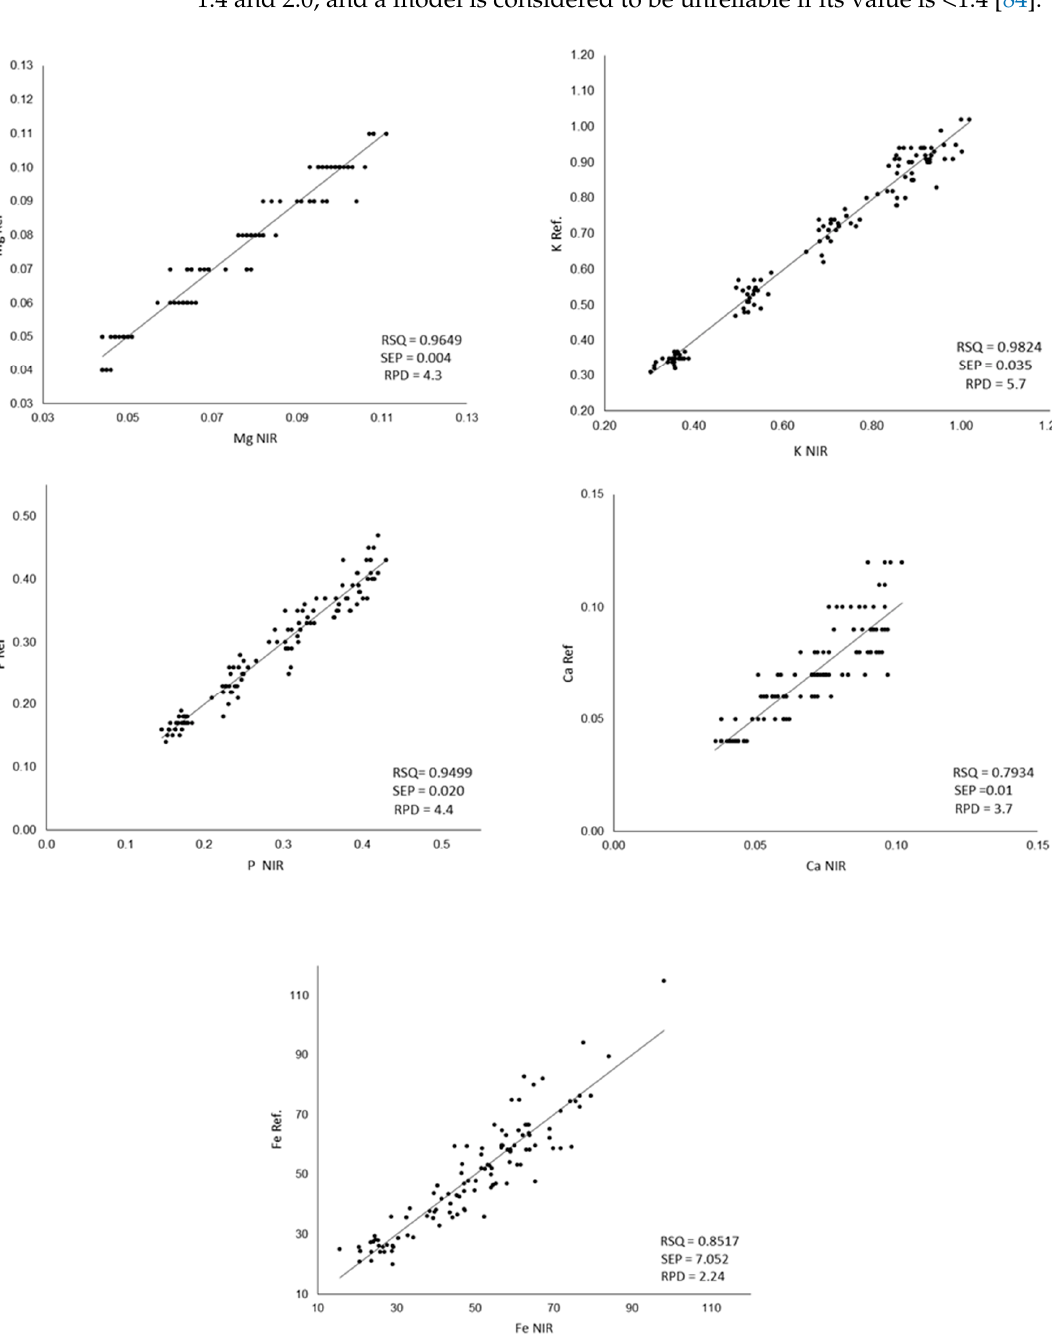
Figure 3. Comparison between the values measured by ICP-MS (Ref.) and the values predicted by the developed equations (NIR); RPD: ratio performance deviation; SEP: standard error of prediction, RPD: relative percent deviation. The Ca, Mg, K and P content was expressed as g/100 g of flour, and Fe content was expressed as mg/Kg of flour.